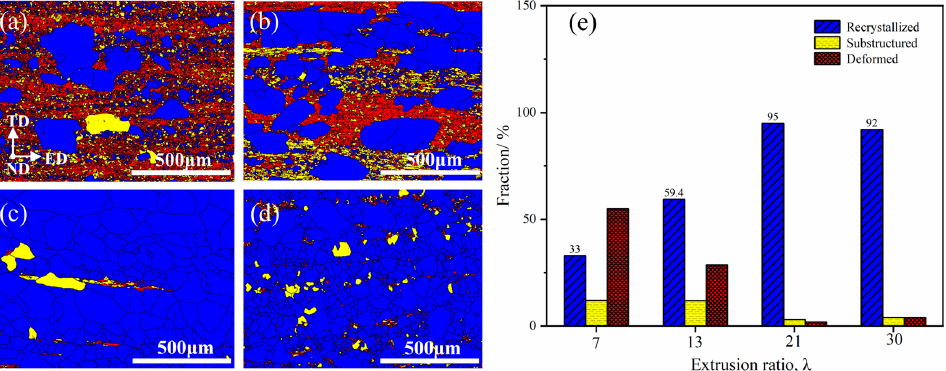
Figure 7. DRX distribution and statistical results of extruded alloys: ( a ) λ = 7, ( b ) λ = 13, ( c ) λ = 21, ( d ) λ = 30; ( e ) Statistical plot of DRX content ( d ) λ = 30; ( e ) Statistical plot of DRX